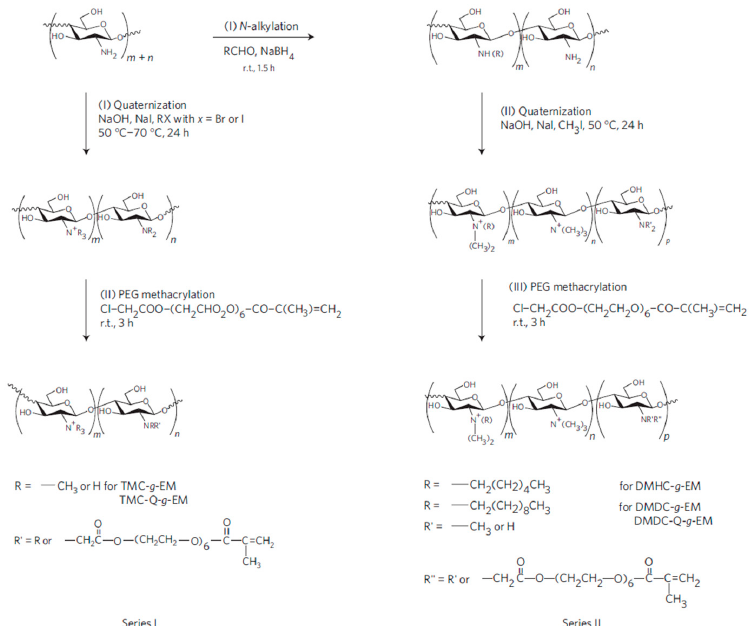
Figure 12. Scheme of the synthesis for the fabrication of modified chitosan antimicrobial hydrogels. Trimethylammonium chitosan-g-poly(ethylene glycol) methacrylate (TMC-g-EM), dimethylhexylammonium chitosan-g- poly(ethylene glycol) methacrylate (DMHC-g-EM) and dimethyldecylammonium chitosan-g- poly(ethylene glycol) methacrylate (DMDC-g-EM) and dimethyldecylammonium chitosan (with high quaternization)-graft-poly(ethylene glycol)